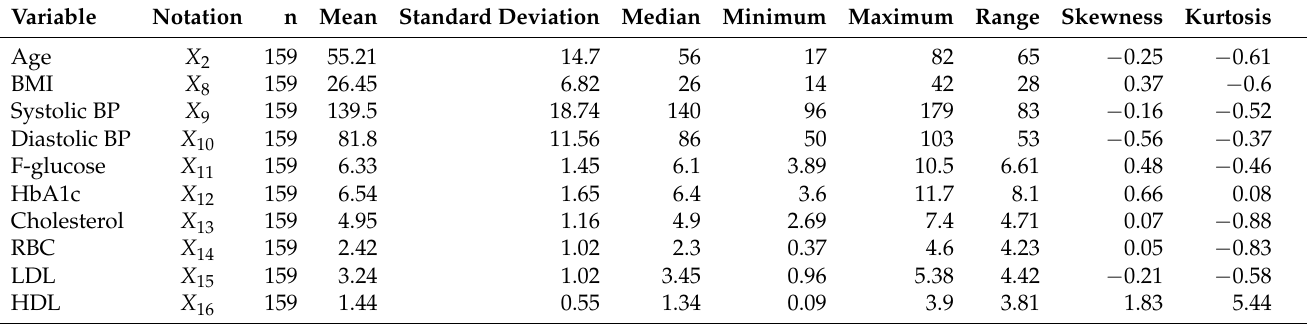
Table 3. Descriptive statistics of the continuous variable under study; see abbreviations in Nomenclature.